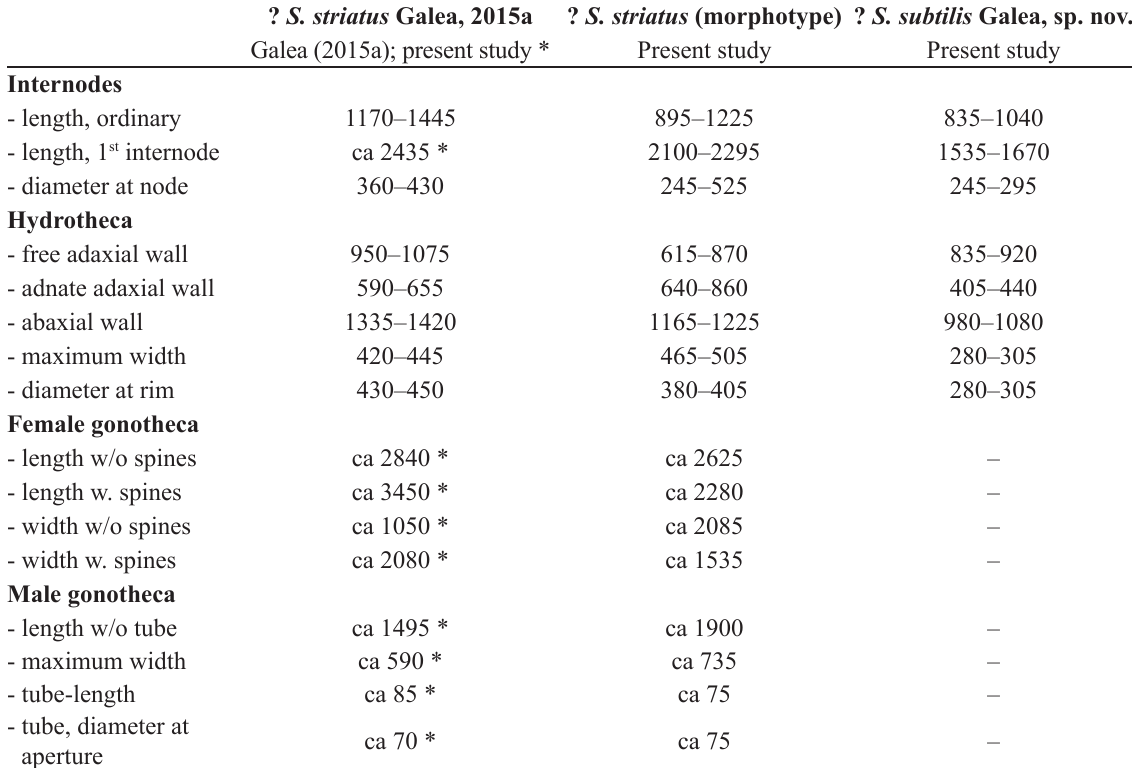
Table 1. Measurements of ? Solenoscyphus spp., in